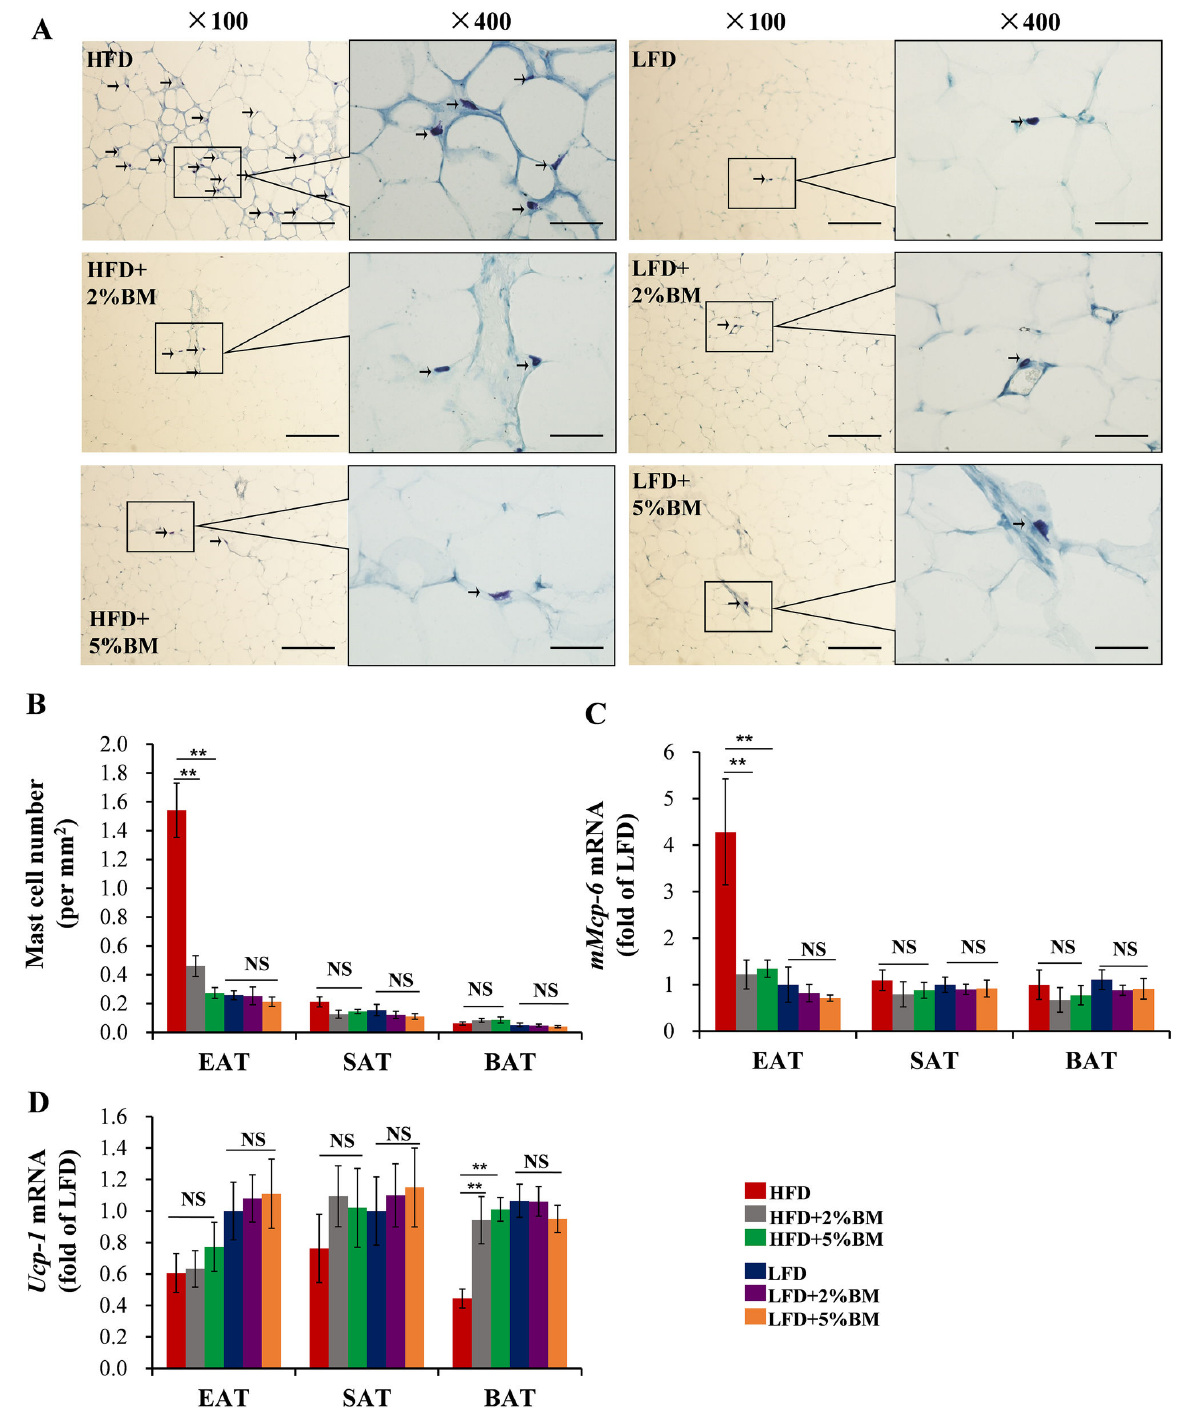
Figure 6. BM inhibited recruitment of mast cells in EAT of mice. (A)Toluidine blue staining of mast cells in EAT of mice; arrows indicate toluidine blue staining mast cells; scale bars in (A), 100μm in length in low power views (×100) and 25μm in length in high power views (×400). (B) The quantification of the numbers of mast cells in EAT, SAT and BAT of mice. (C) The expression of mast cell marker gene m Mcp-6 in EAT, SAT and BAT of mice. (D) The expression of energy expenditure marker gene Ucp-1 in EAT, SAT and BAT of mice. Statistical difference between groups is shown using a nonparametric Mann-Whitney test. n=8 per group. * P <0.05, ** P <0.01. All data in (B)-(D) are means ± SEM. doi: 10.1371/journal.pone.0084075.g006 PLOS ONE |